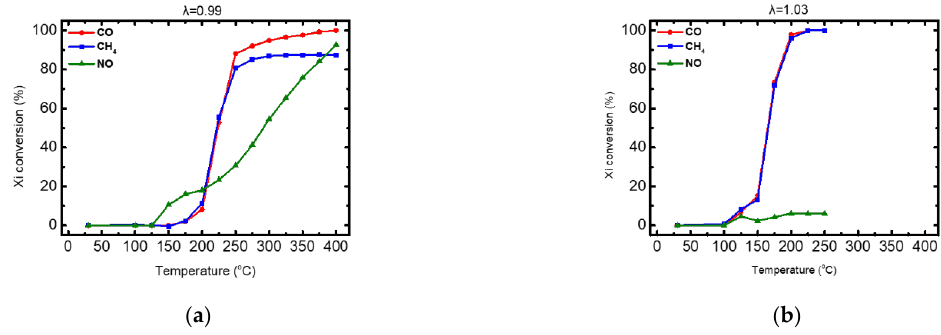
Figure 17. Light-off curves for the conversion of CO, CH 4 and NO.